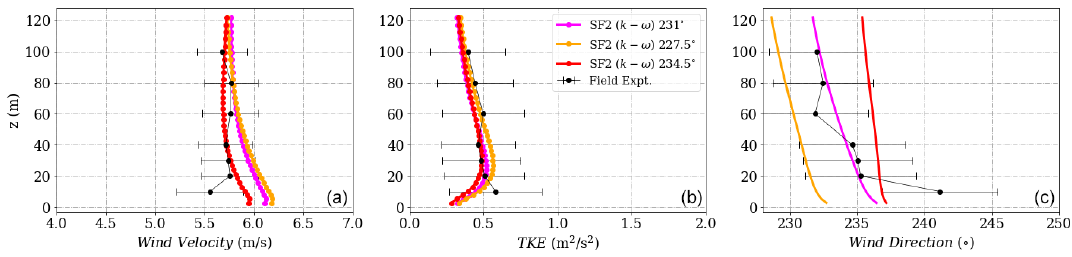
Figure D1. (a) Wind velocity magnitude, (b) wind direction and (c) turbulent kinetic energy tuned to reach calibration at height 573m corresponding to 100m at Tower 20 (tse04) for the SF2 ( k − ω ) model.